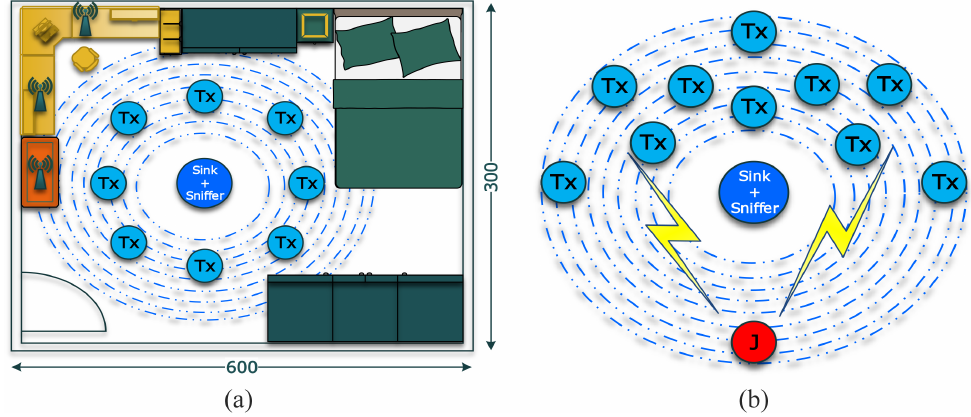
Figure 6. ( a ) The bedroom used for the experiments when the reactive strategy is used, ( b ) The fixed position of the constant jammer for the